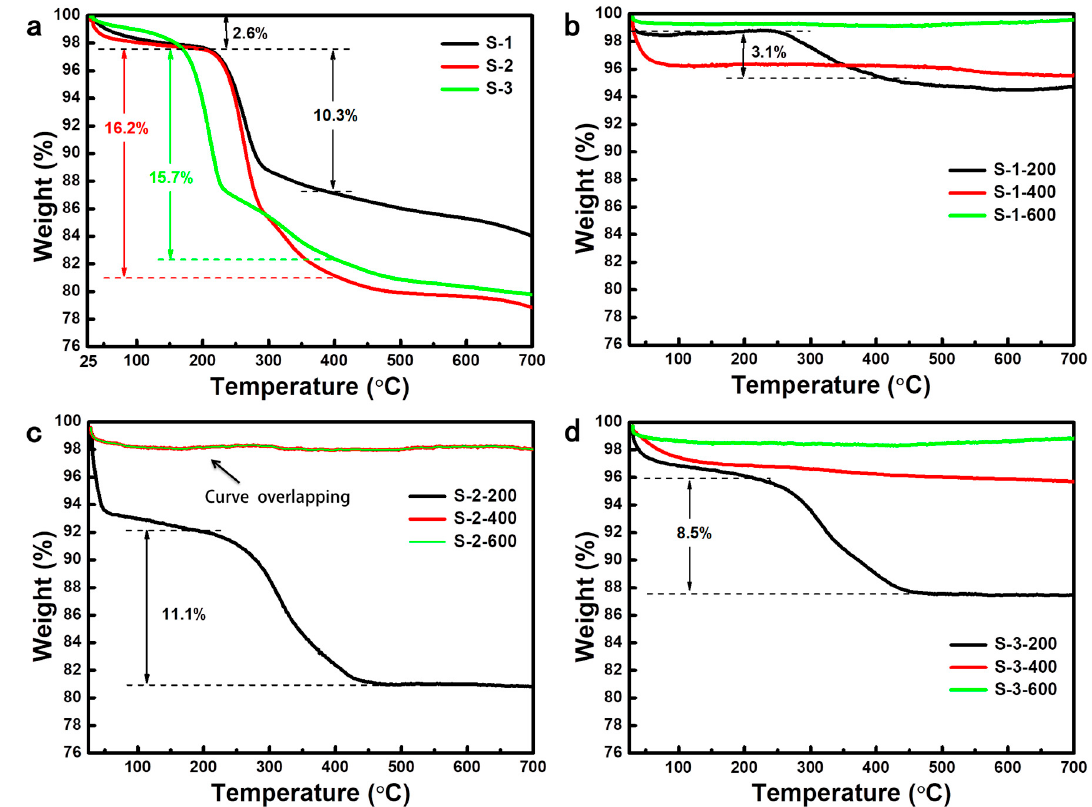
Figure 6. Weight loss curves of the silica aerogels: ( a ) S-1, S-2, and S-3; ( b ) S-1-200, S-1-400, and S-1-600; ( c ) S-2-200, S-2-400, and S-2-600, the curve of S-2-600 is almost overlapped with that of S-2-400; ( d ) S-3-200, S-3-400, and S-3-600.